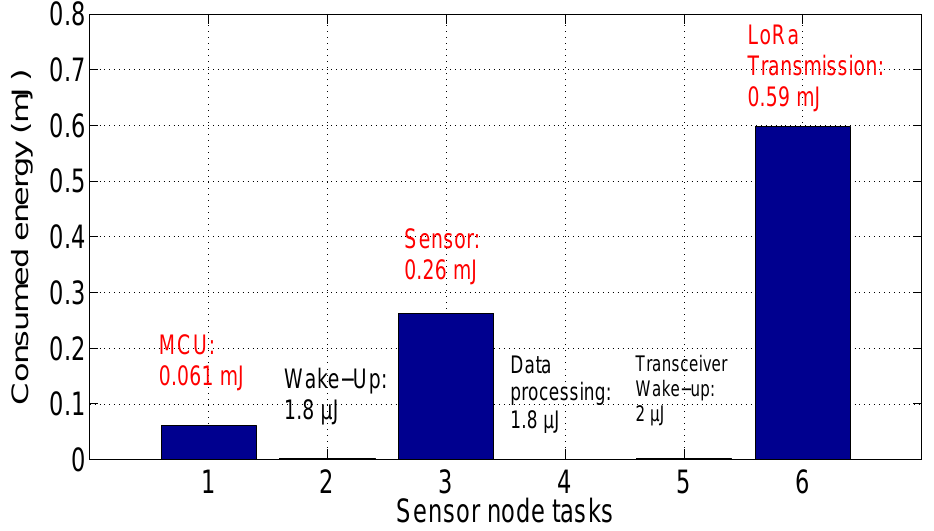
Figure 15. Energy consumption of sensor node: Scenario 1.